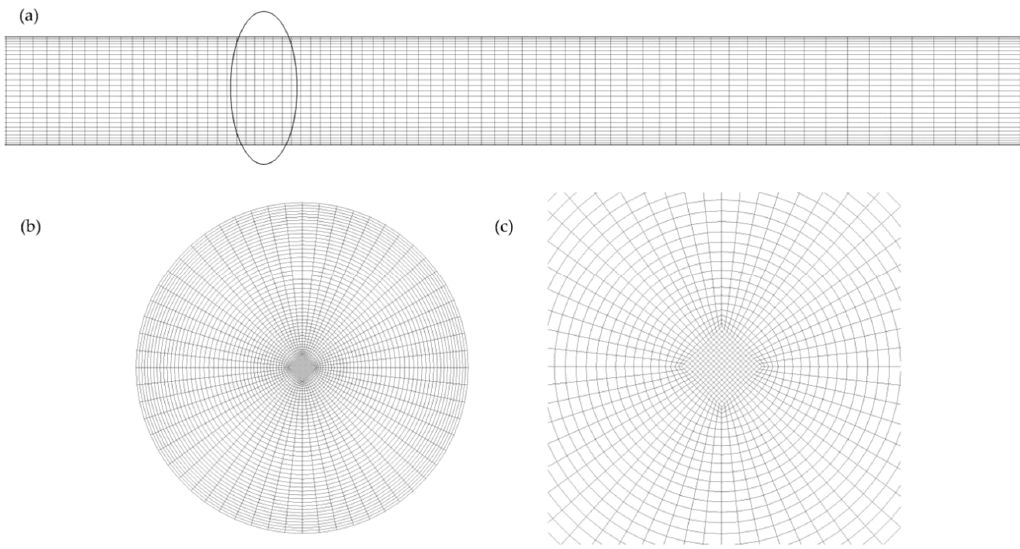
Figure 2. The details of constructed mesh: ( a ) axial cross-section, ( b ) radial cross-section, ( c ) close-up of the pipe center.